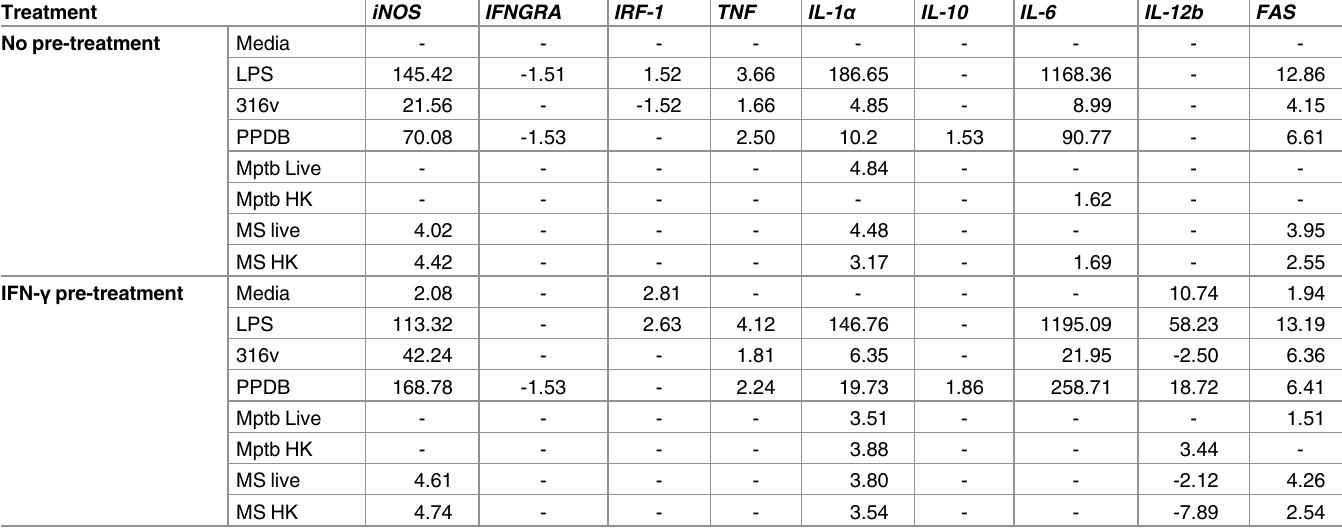
Results are expressed as fold change compared to media with no pre-stimulation. Negative values indicate downregulation. Changes < 1.5 fold were considered to be not regulated. These are shown as “-“and were comparable to the media